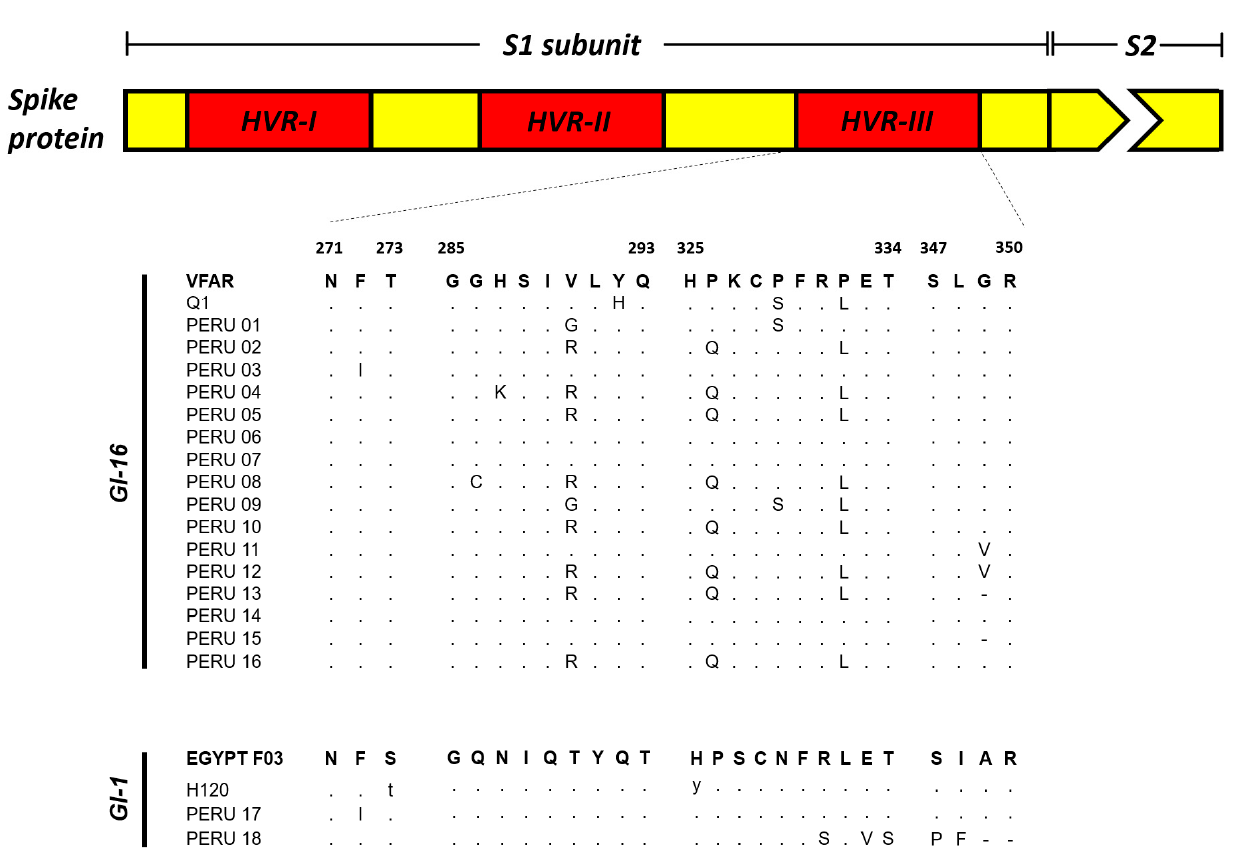
Figure 4. Schematic representation of amino acid changes detected in the IBV belonging to GI-16 and GI-1 lineages: S1 subunit hypervariable region III (HVR-III) of the spike amino acid sequence was compared among the Peruvian isolates and the closest relatives and a representative strain of each GI-16 and GI-1 lineages. Amino acid changes are represented with different letter and those conserved are presented in dots.